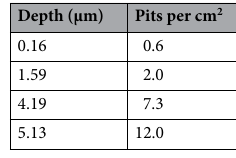
Table 2. Number density of the fracture pit